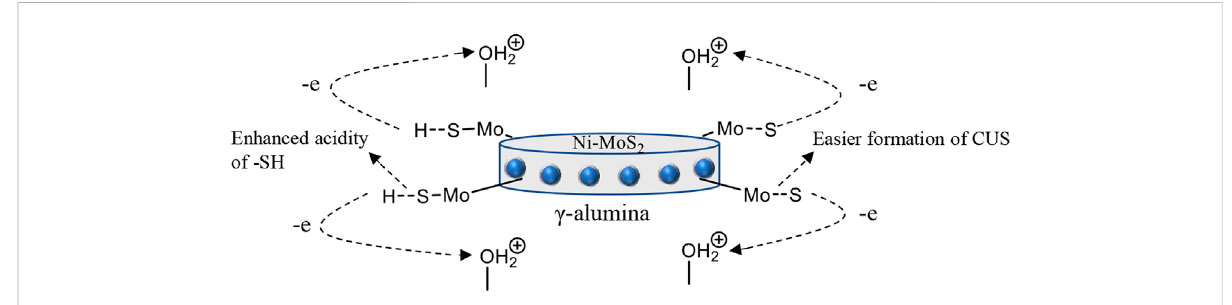
FIGURE 4 A representation of an alumina supported catalyst showing the movement of electrons on the active